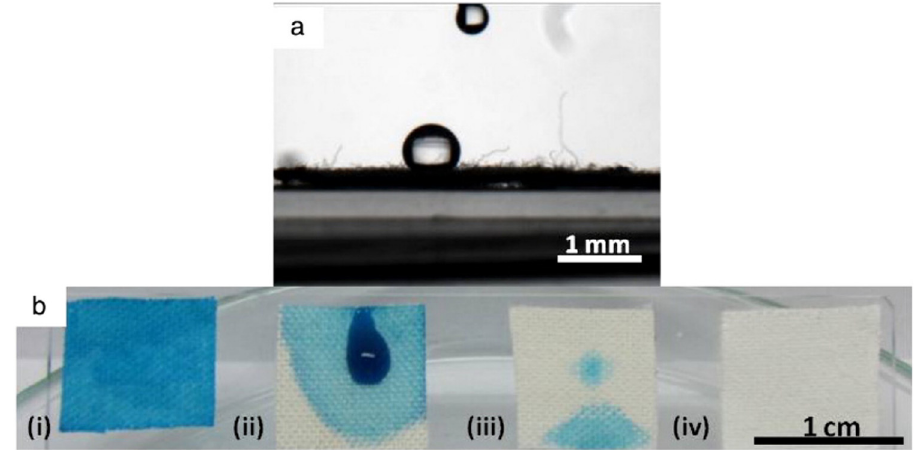
Figure 19: ( a ) Water contact angle measurement of surface - modi fi ed ZnO NW coated cotton fabric. ( b ) Digital picture of ( i ) bare, ( ii ) coated with ZnO seeds, ( iii ) coated with ZnO NWs, and ( iv ) cotton fabrics after methylene blue solution staining. Reproduced with permission from Elsevier [ 346 ]